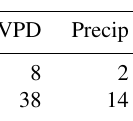
Table 1. Number of FLUXNET sites where each regression coeffi- cient is statistically significant to explain the physio-phenology of GPPmax (DOY GPPmax ). The table is divided by the sign of the co- efficient. The first column is the coefficient for the dimensionality reduction between air temperature (Tair), shortwave incoming radi- ation (SWin), and vapor pressure deficit (VPD); the second column is the coefficient for precipitation (Precip). Climatic variable Sign Tair, SWin, VPD Precip